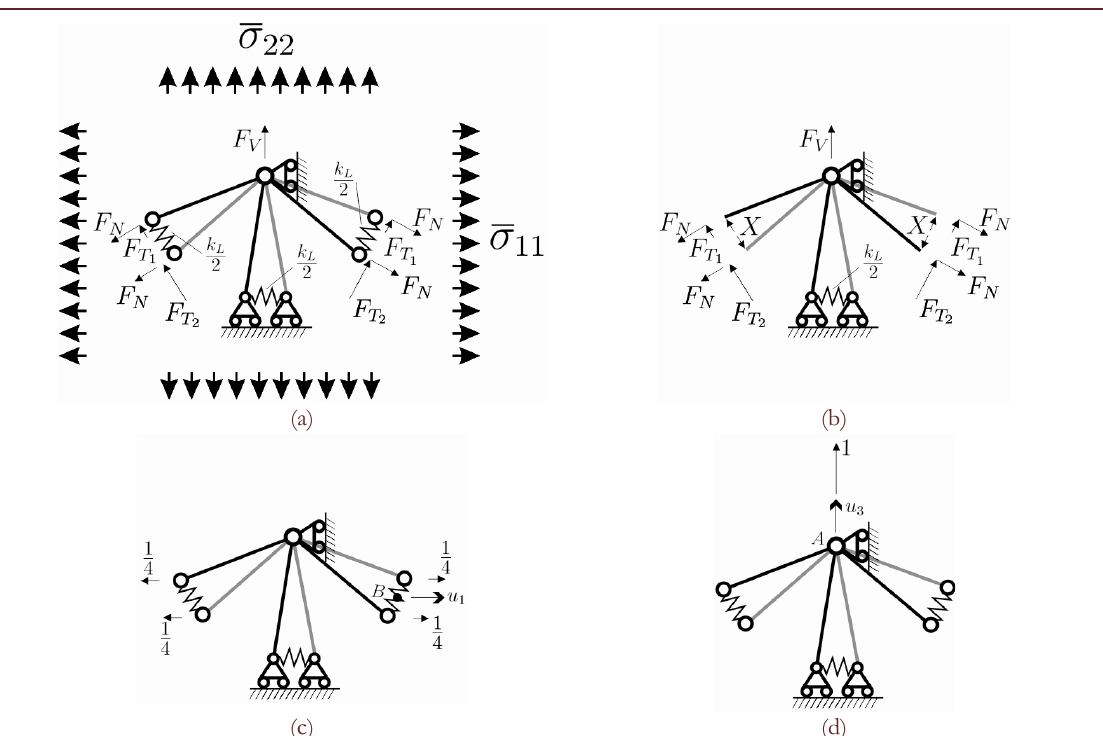
Figure 5: Application of the Principle of Virtual Displacements. Lattice reinforced with longitudinal springs. (a) Simplified structured analyzed for the computation of the effective properties. The applied forces F N, F V , F T1 and F T2 correspond to macroscopic stresses components. (b) Disconnected statically determined structure introduced for the determination of the internal actions (M,N,S L ). (c-d) Statically determined structure adopted for the computation of the displacement of the points A and